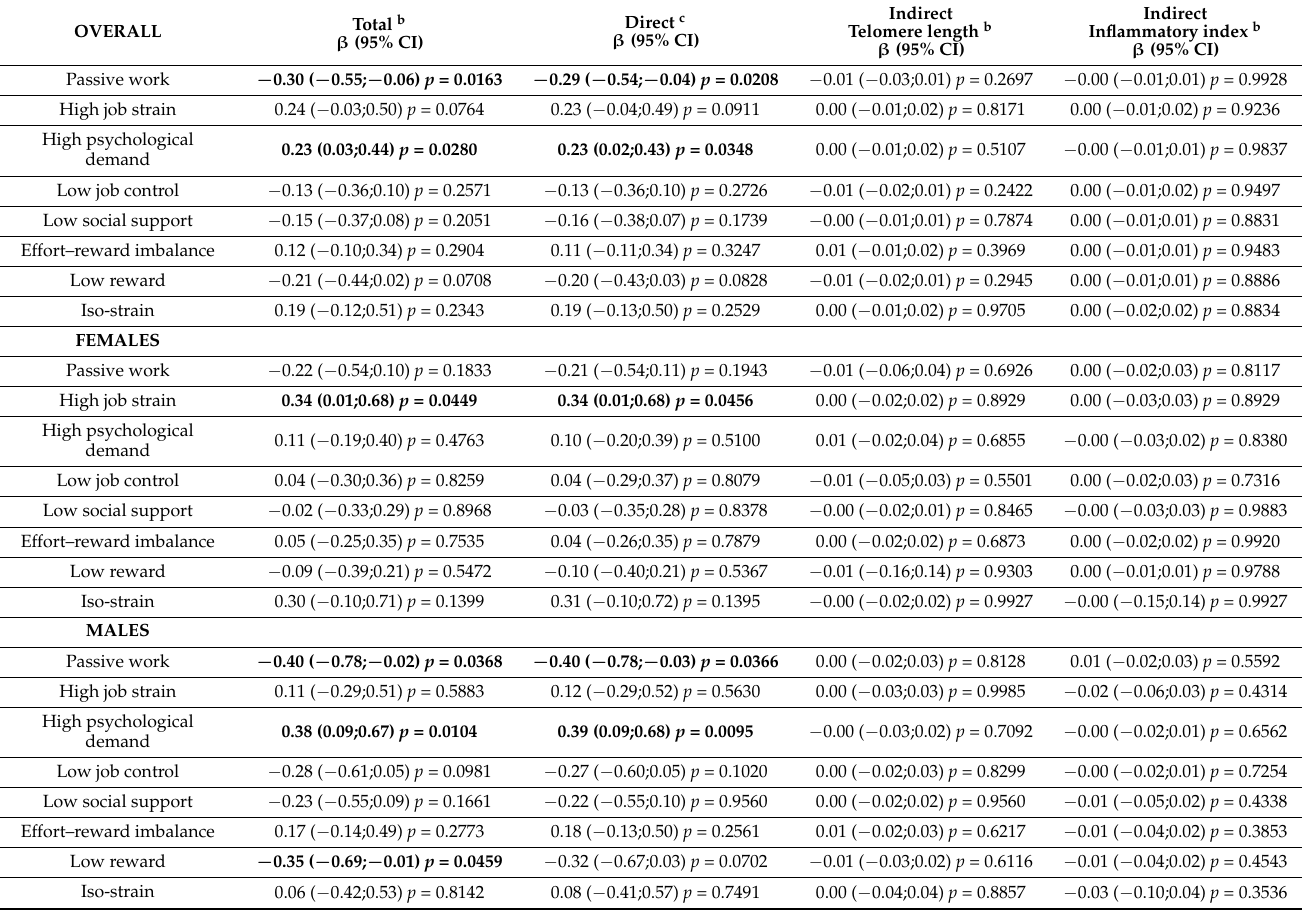
Table 4. Association between work-related psychosocial factors at T2 and global cognitive function at T3: total, direct, and indirect a associations through telomere length and inflammatory index, overall and by